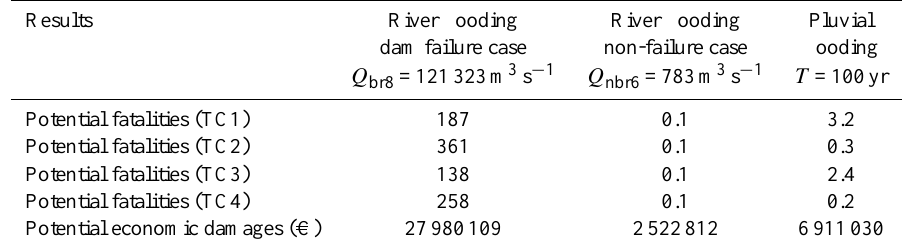
Table 11. Example of estimated potential fatalities and economic damages for the DEAP-Case (river flooding including dam failure and flood routing).